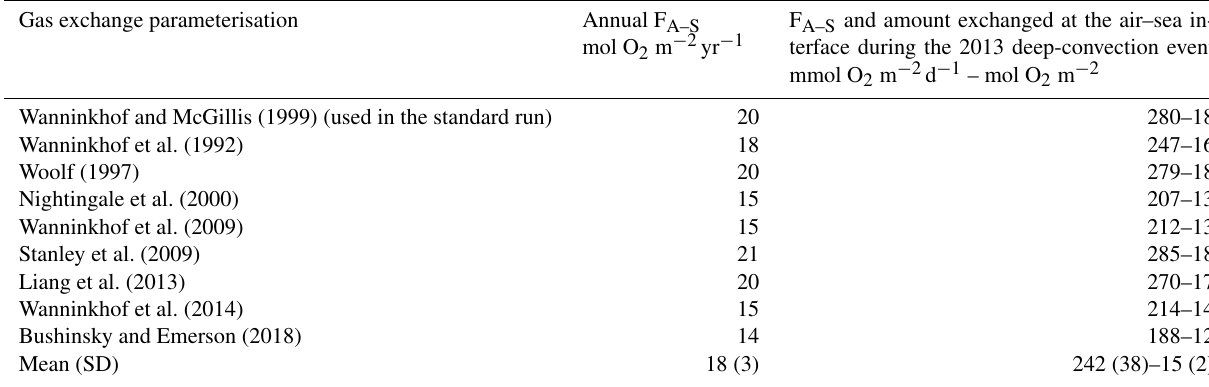
Table 2. Estimates of air-to-sea oxygen flux (F A–S ) for the period September 2012–September 2013 and during the deep convection (15 January–8 March, 15–24 March), using different parameterisations of gas transfer